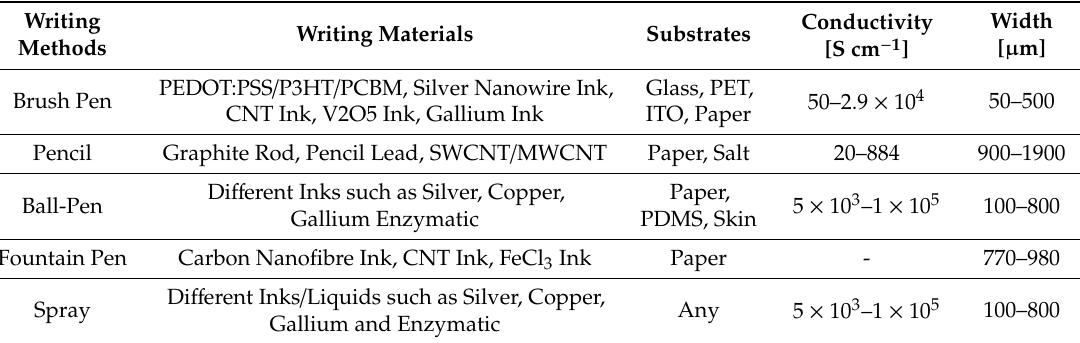
Table 9. Comparison of handwriting methods